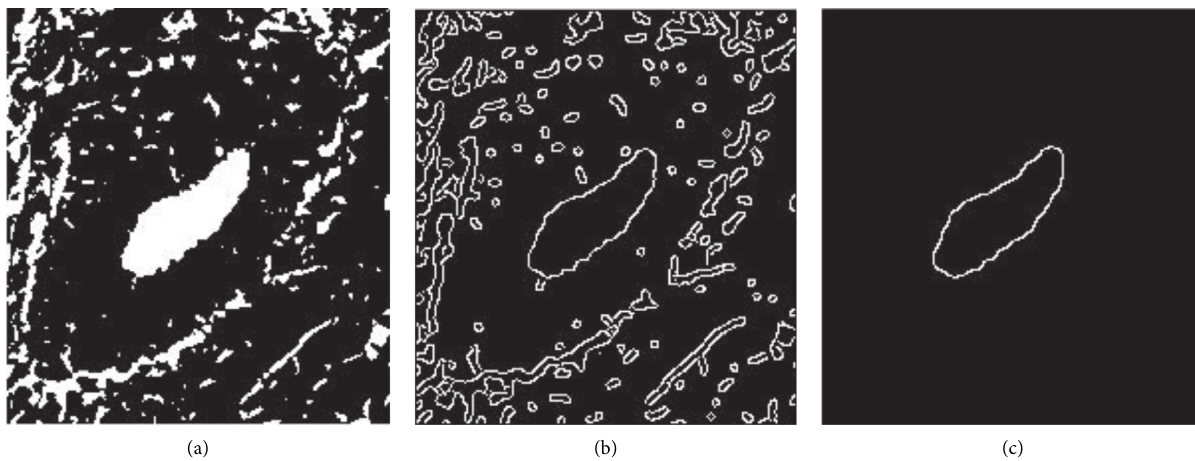
Figure 5: Extraction of lumens from the background channel. (a) The background stain intensity map. (b) The segmentation image using SPF, which contains small background areas. (c) The lumen outline after removing the small